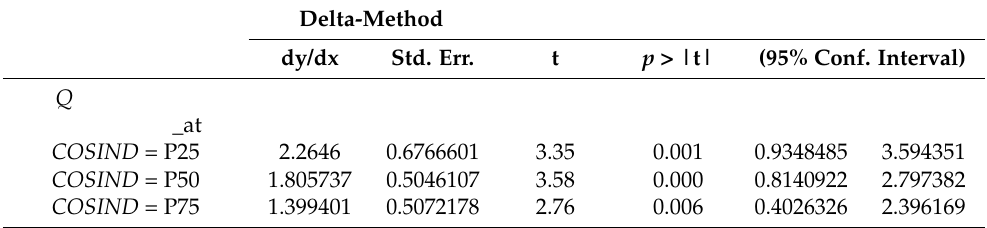
Table 6. The impact of the costly CSR indicator on investment sensitivity to Q. Delta-Method dy/dx Std.